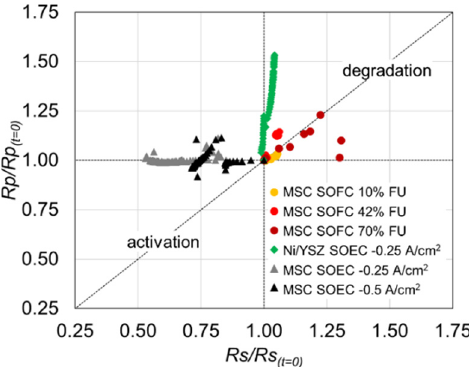
Figure 10. Ratio between serial (Rs) and polarization (Rp) resistance change compared to start of operation ( Rs ( t = 0) ), Rp ( t = 0) ). MSC in SOFC mode (circles) with 10% FU (orange), 42% FU (red), 70% FU (dark red), Ni/YSZ cell (green diamonds), MSC in SOEC mode at − 0.25 A/cm 2 (grey triangles), and MSC in SOEC mode at − 0.5 A/cm 2 (black triangles).